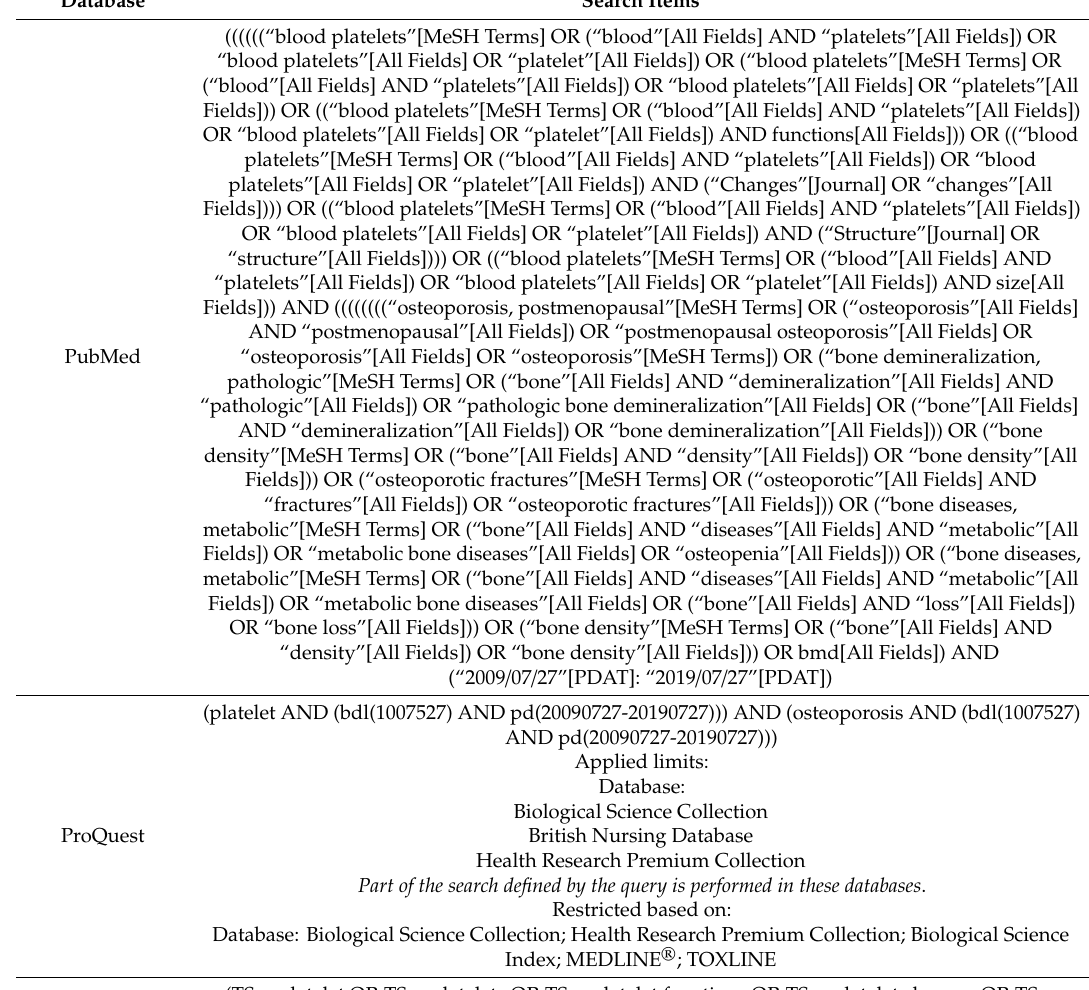
Table 1. Search terms used in the PubMed, ProQuest, Scopus, Web of Science Core Collection and Cochrane Central Register of Controlled